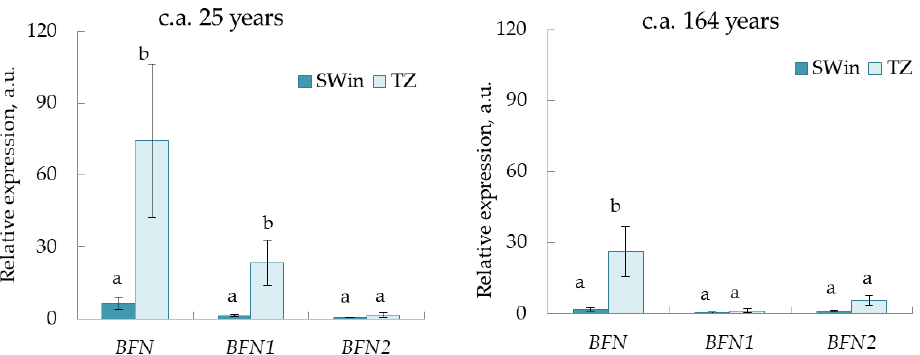
Figure 6. Relative expression (arbitrary units) of PCD genes in the transition zone (TZ) and inner sapwood (SWin) of 25 and 164 cambial age (c.a.) years Scots pine trees. Values represent the mean ± SE ( n = 5). The difference was considered significant if p < 0.05. Letters indicate differences between SWin and TZ for each gene.